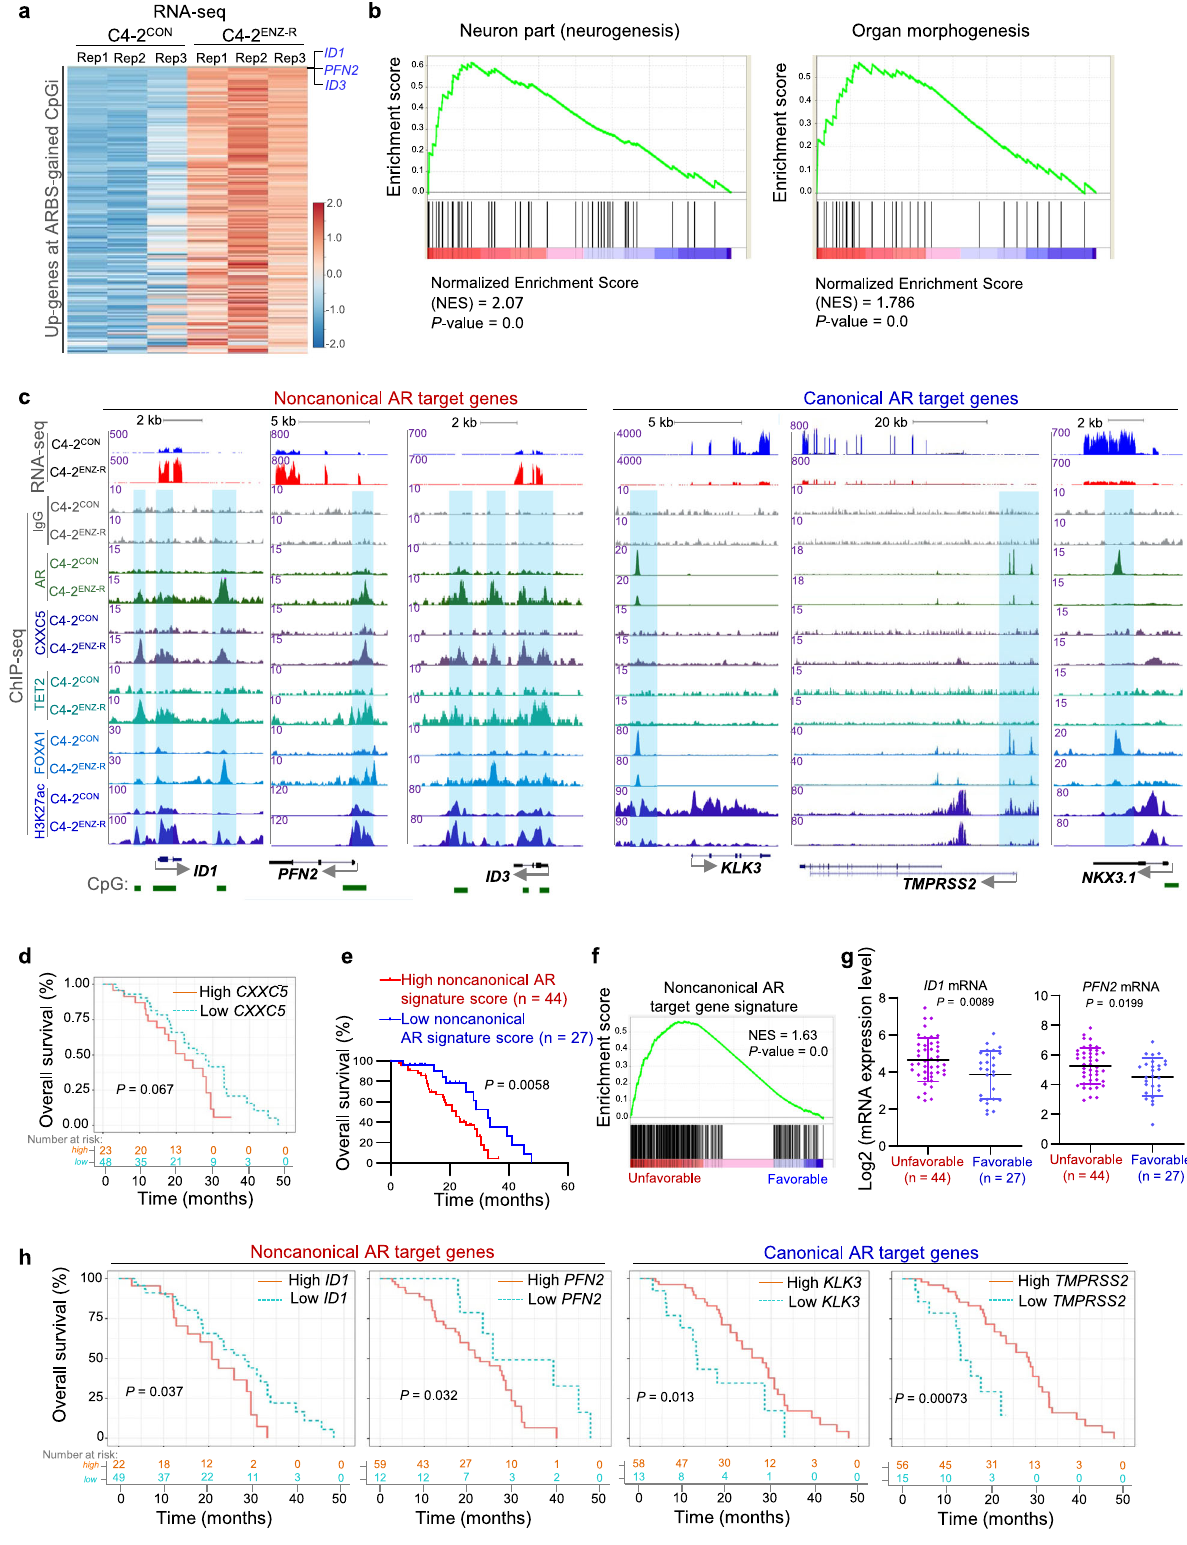
rationale to investigate the therapeutic ef fi cacy of NEO1132 and NEO2734, two dual inhibitors of BET and CBP/p300 proteins 44 in ENZ-R CRPC cells. We found that C4-2 ENZ-R cells were sensitive to both NEO1132 and NEO2734 and that the ef fi cacy of NEO2734 was much greater at lower doses (Fig. 5b). We there- fore chose to test the effect of NEO2734 in other ENZ-R